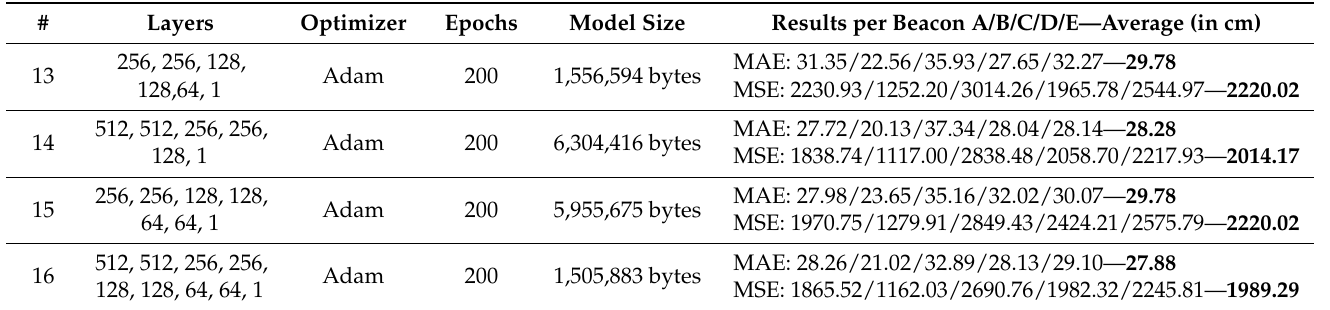
Table 6. Experiments No. 13, 14, 15, and 16 parameters and